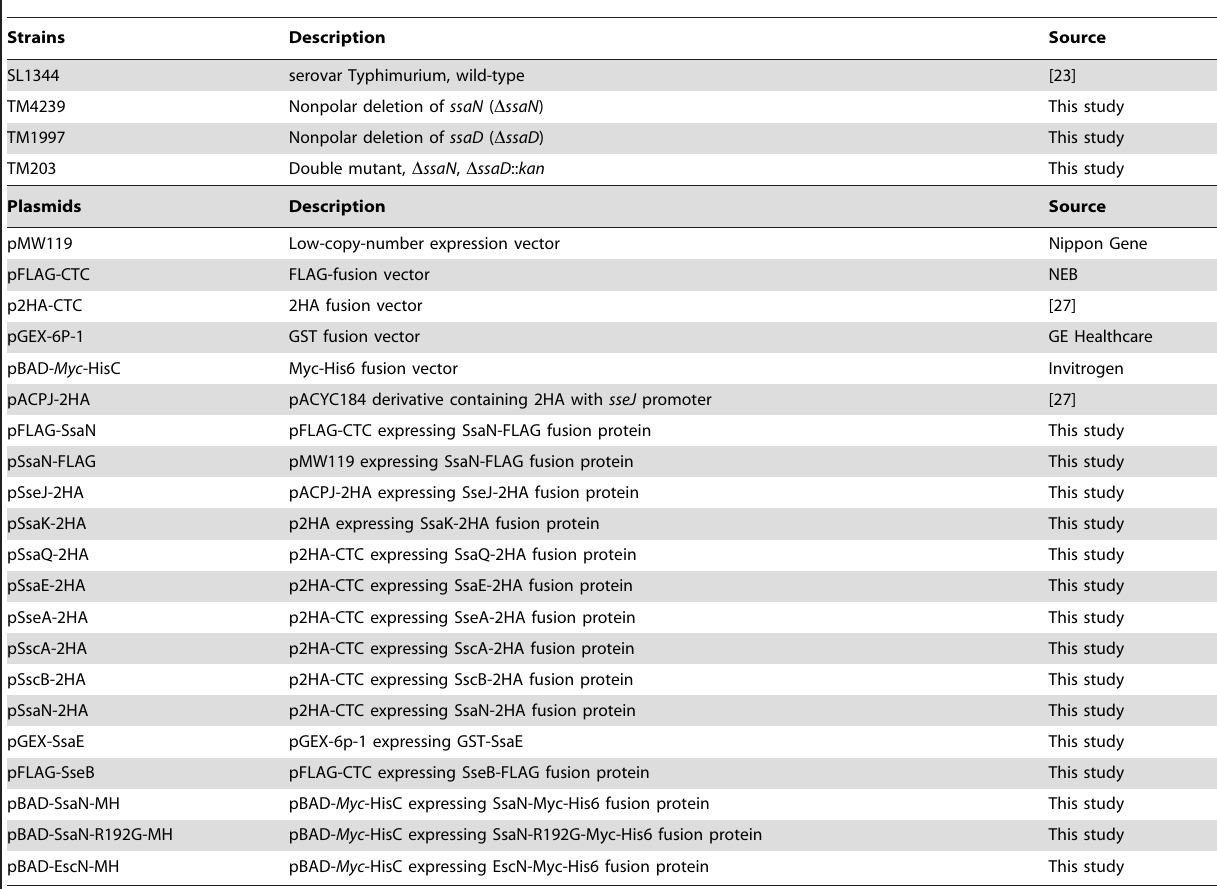
Table 1. Salmonella strains and plasmids used in this study.